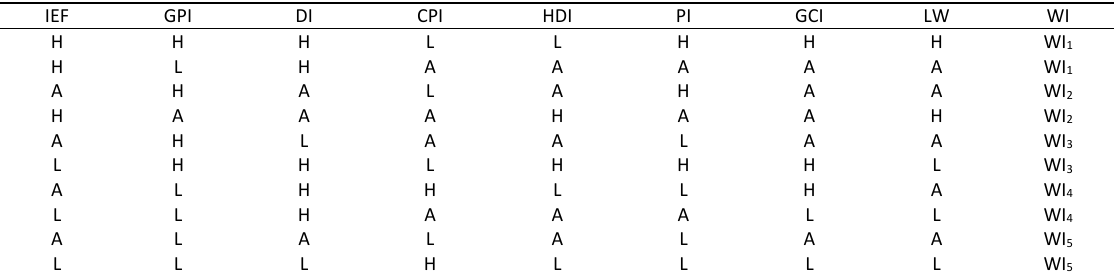
Table 3: Knowledge base of Welfare Index